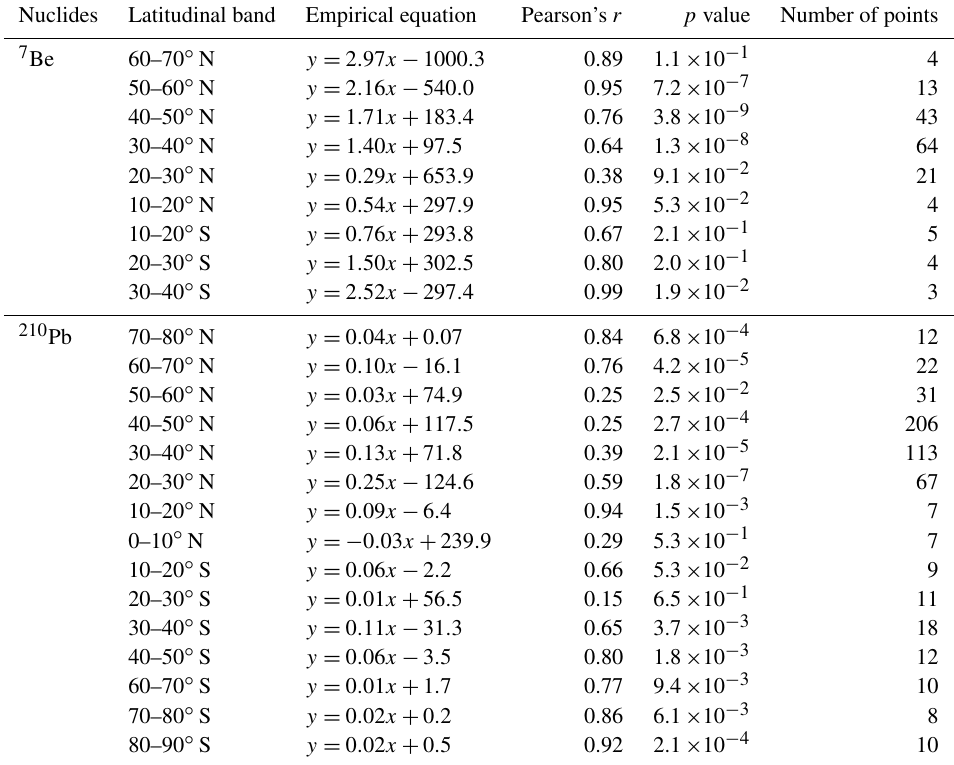
Table 2. A summary of empirical equations and fitting parameters describing the relationships between annual precipitation ( x ) and 7 Be and 210 Pb annual depositional fluxes ( y ) for different latitudinal bands.